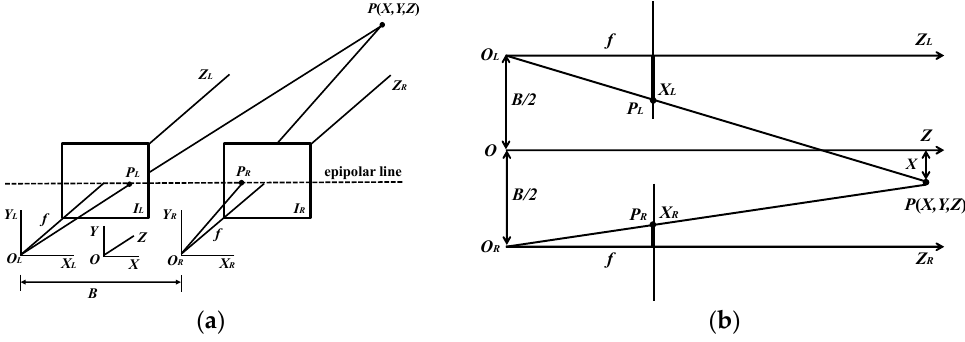
Figure 9. Stereovision system geometry with parallel optical axes (images from [73]): ( a ) mapping of 3D point P ( X ,Y,Z) onto image planes; ( b ) geometric parameters on similar triangles.